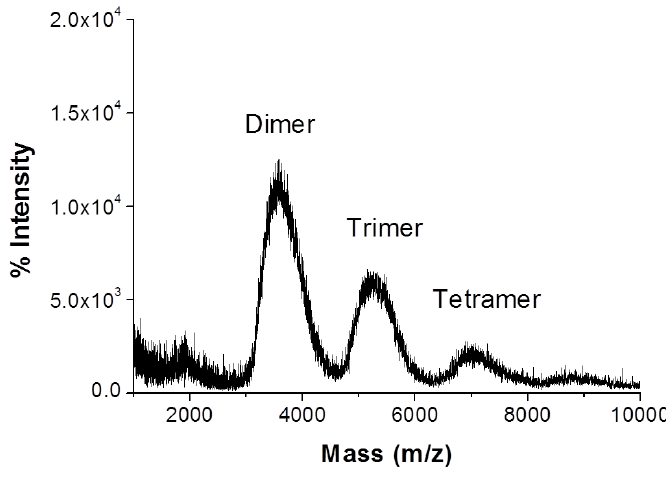
Figure 2. MALDI-TOF mass spectrum of HP- β Figure 2 . MALDI-TOF mass spectrum of HP-β-CD-ol. Figure 2 . MALDI-TOF mass spectrum of HP-β-CD-ol.